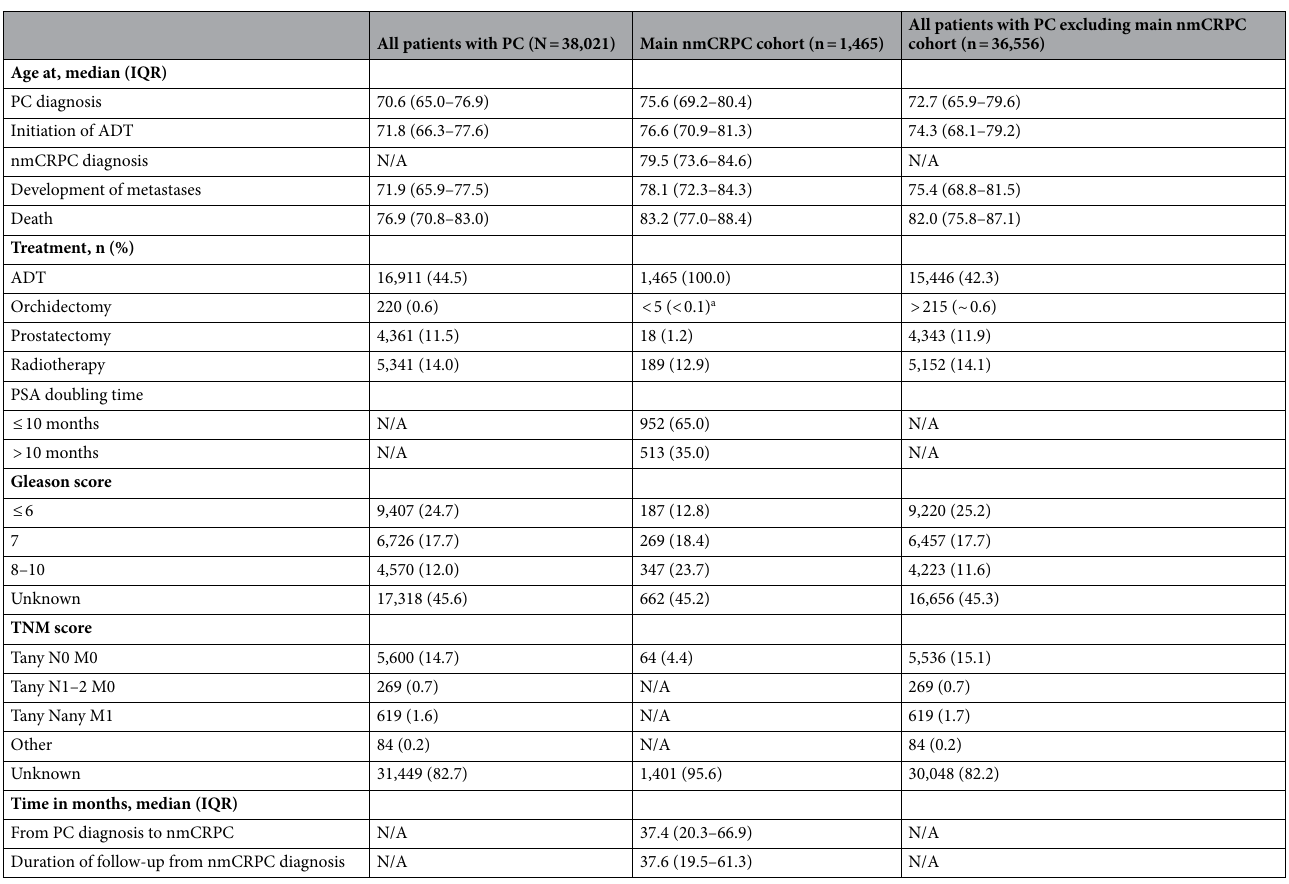
Table 1. Patient demographics and baseline characteristics. ADT: androgen deprivation therapy; IQR: interquartile range; N/A: not available; nmCRPC: non-metastatic castration-resistant prostate cancer; PC: prostate cancer; PSA: prostate-specific antigen; TNM: tumor, node, metastasis. a This result is presented as ‘ <